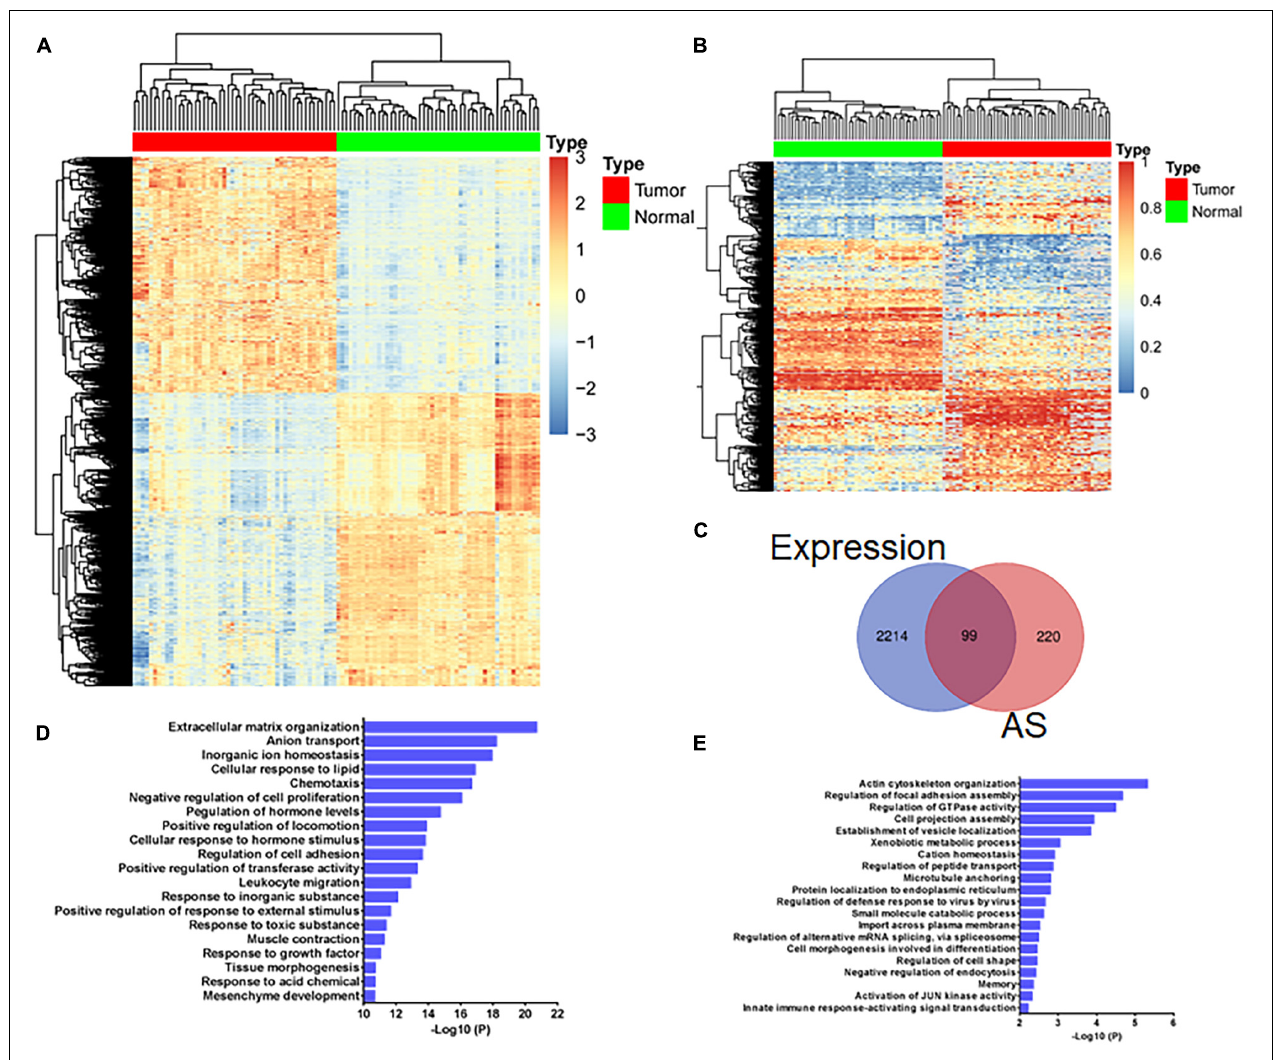
FIGURE 1 | Gene expression analysis and gene alternative splicing (AS) event analysis reveal different transcriptome characteristics associated with colorectal cancer development. (A) Heatmap shows 2,313 differentially expressed genes ( A , log2FC > 1, adjusted p -value < 0.01) and (B) 338 differentially expressed AS events of 319 genes (difference > 0.2, FDR < 0.01) between 50 paired normal and tumor tissues. (C) Venn diagram displays the overlapping genes with differentially expressed mRNA levels and AS events between 50 paired normal and tumor tissue. (D) GO analysis of genes with differentially expressed mRNA levels and (E) genes with differentially expressed AS